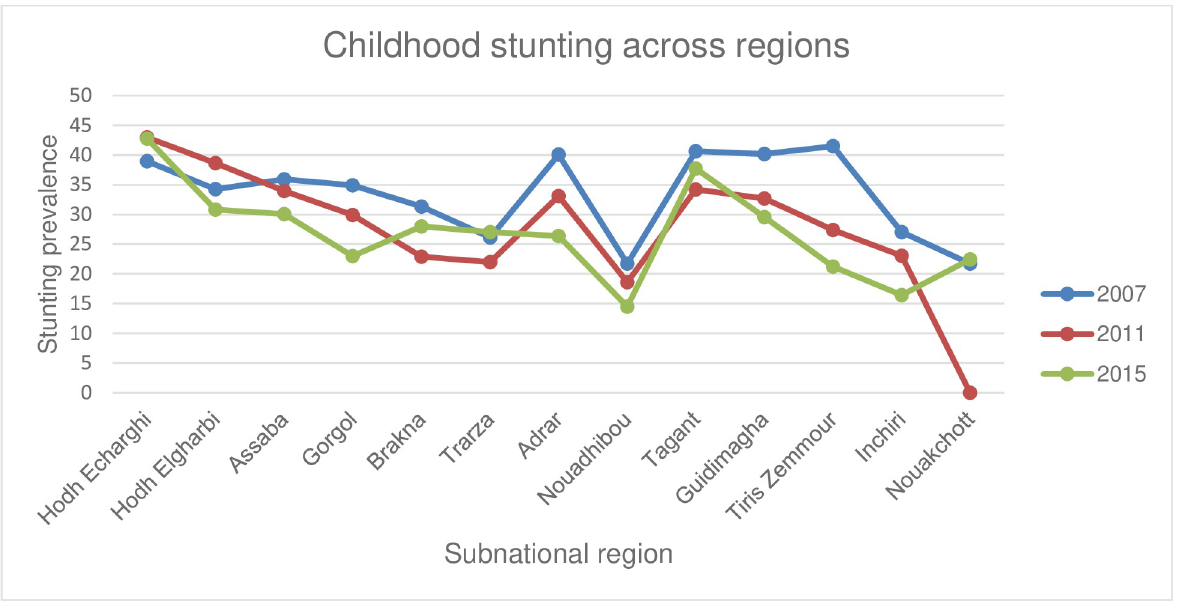
Fig 2. Trends in the prevalence of childhood stunting across the subnational regions in Mauritania, MICS (2007–2015).